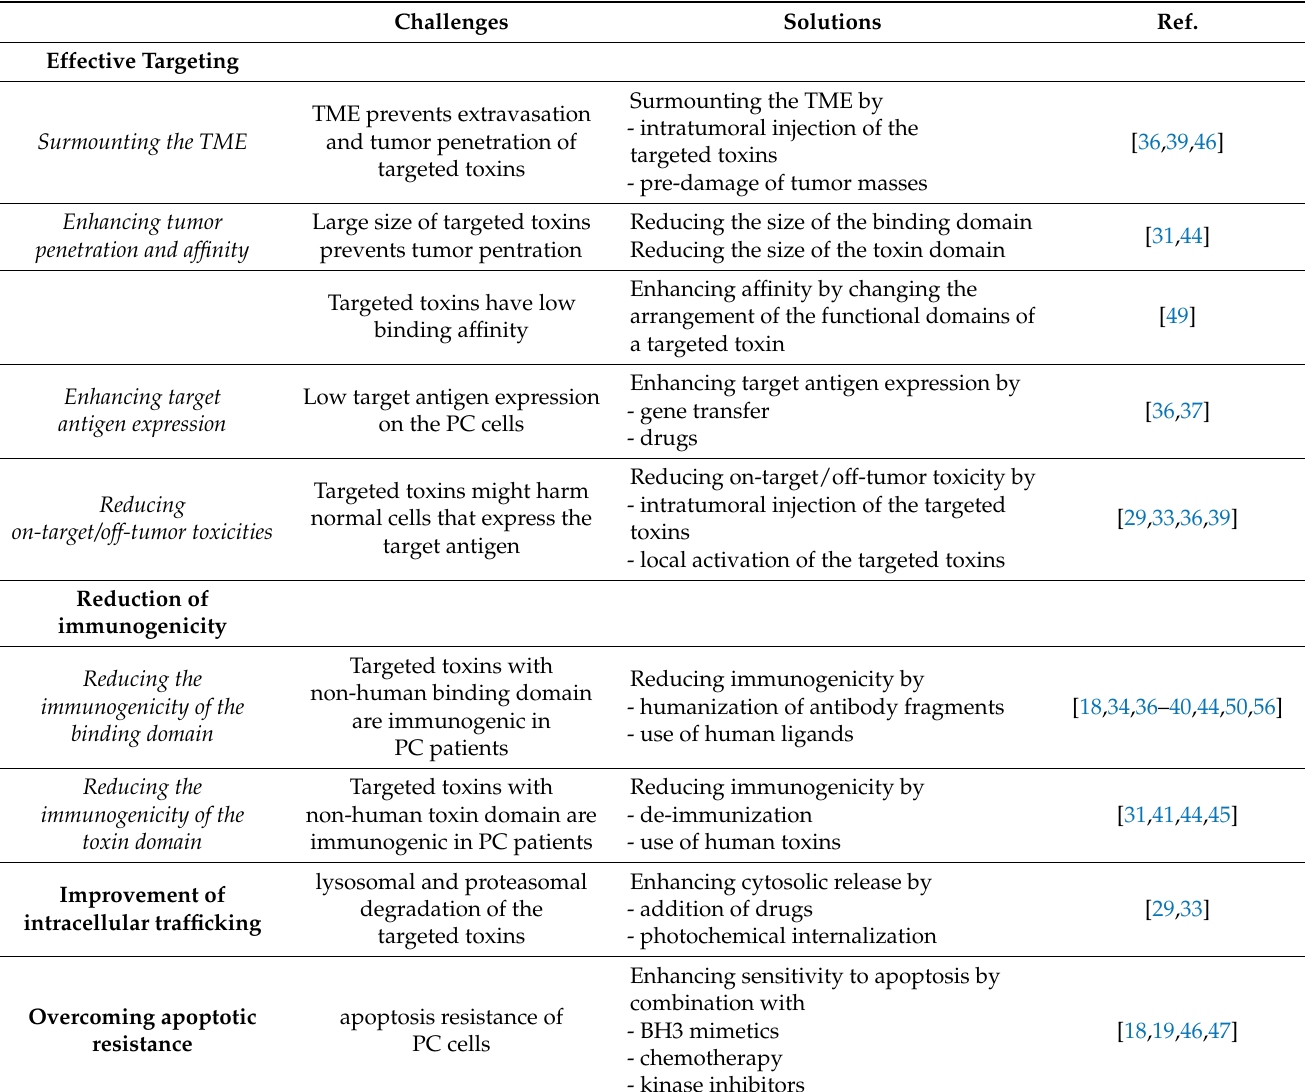
Table 2. Strategies to optimize the efficacy of targeted toxins against prostate cancer. Challenges Solutions